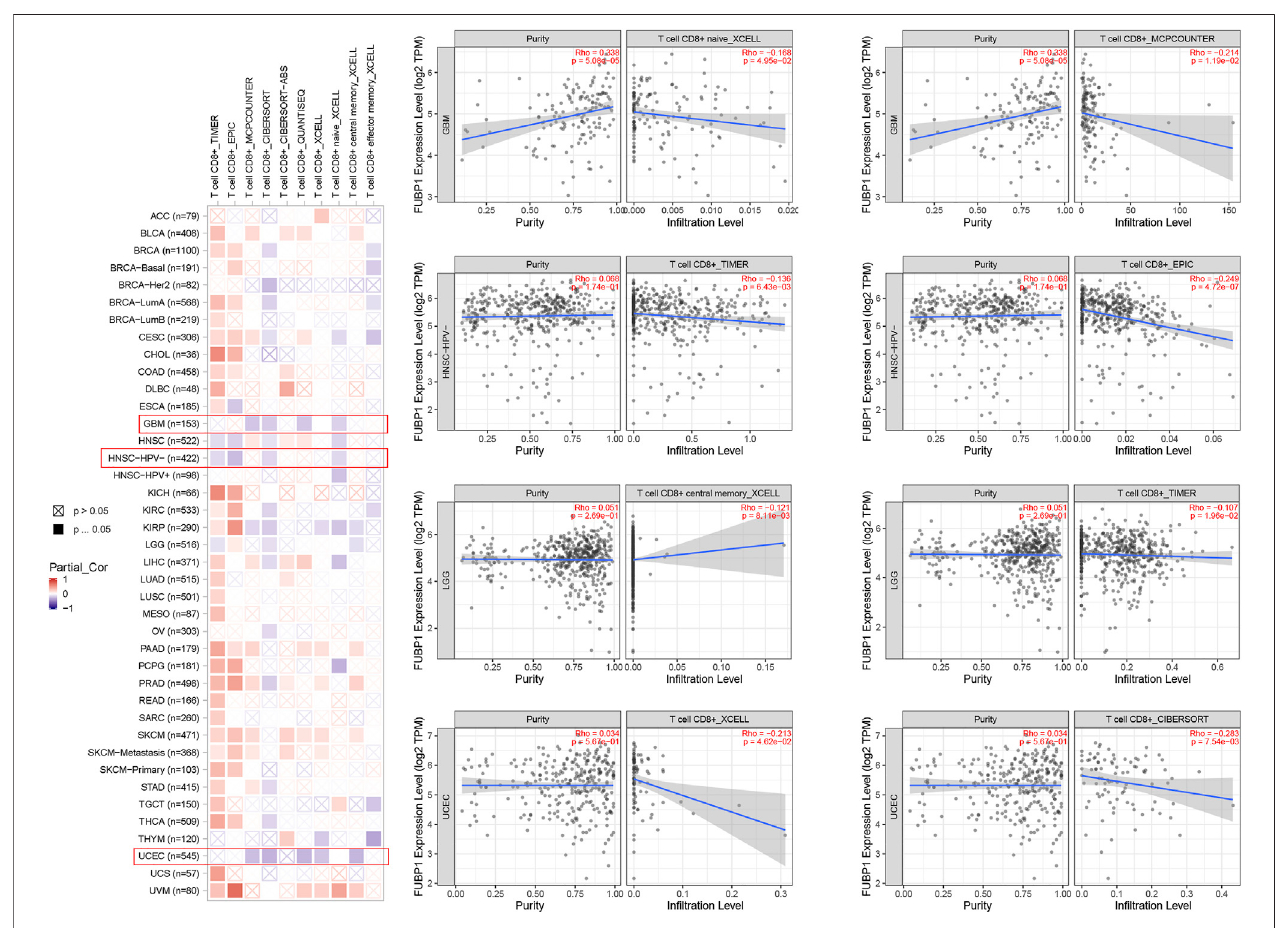
FIGURE6| Correlationanalysis betweenFUBP1 expression and theimmunein fi ltration ofCD8 + Tcells. Multiplealgorithmswere applied toexplore thecorrelation between the expression of FUBP1 and the in fi ltration level of CD8 + T cells in different cancer types in TCGA.